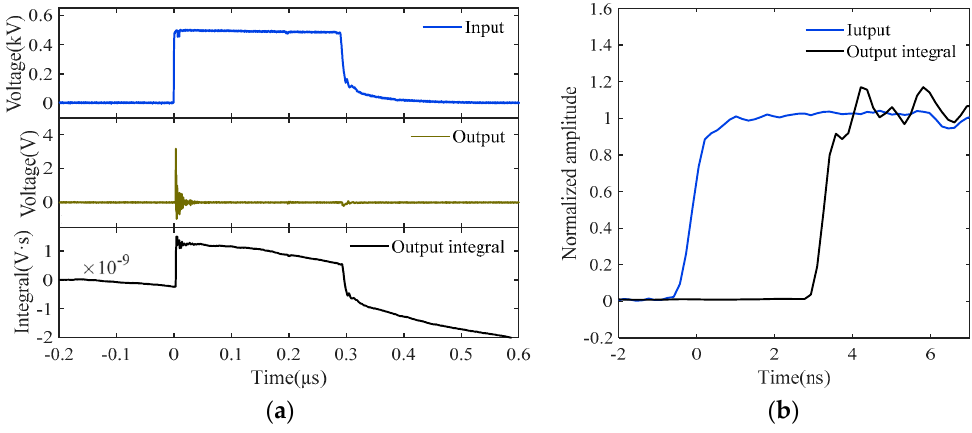
Figure 6. Input excitation, output response, and output integral of D-dot measurement system: ( a ) square wave; ( b ) detailed front edge.